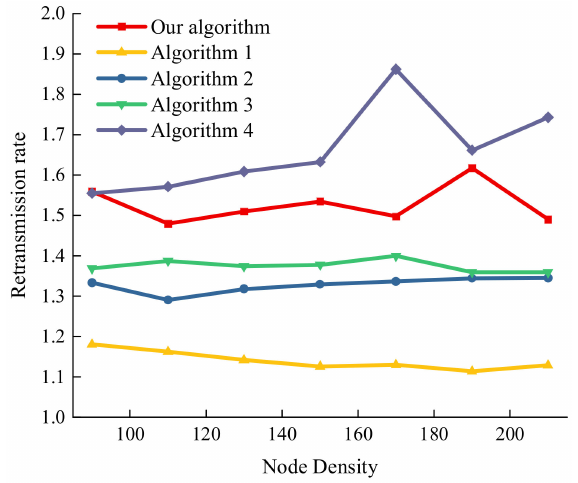
Figure 11. Retransmission rate under a different number of